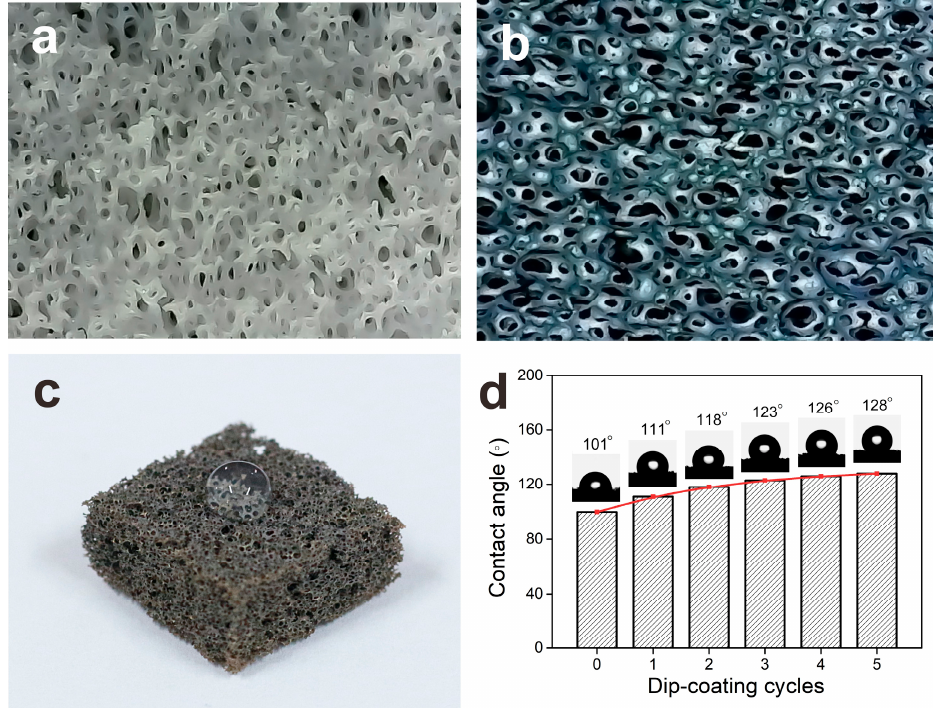
Figure 4. Optical images of ( a ) surface of the original NRLF. ( b ) hydrophobic surface of the Figure4. Opticalimagesof( a )surfaceoftheoriginalNRLF.( b )hydrophobicsurfaceoftheAgNWs / NRLF. AgNWs/NRLF. ( c ) large drop of deionized water on the AgNWs/NRLF. ( d ) change in contact angles ( c ) large drop of deionized water on the AgNWs / NRLF. ( d ) change in contact angles with di ff erent with different dip ‐ coating cycles. dip-coating